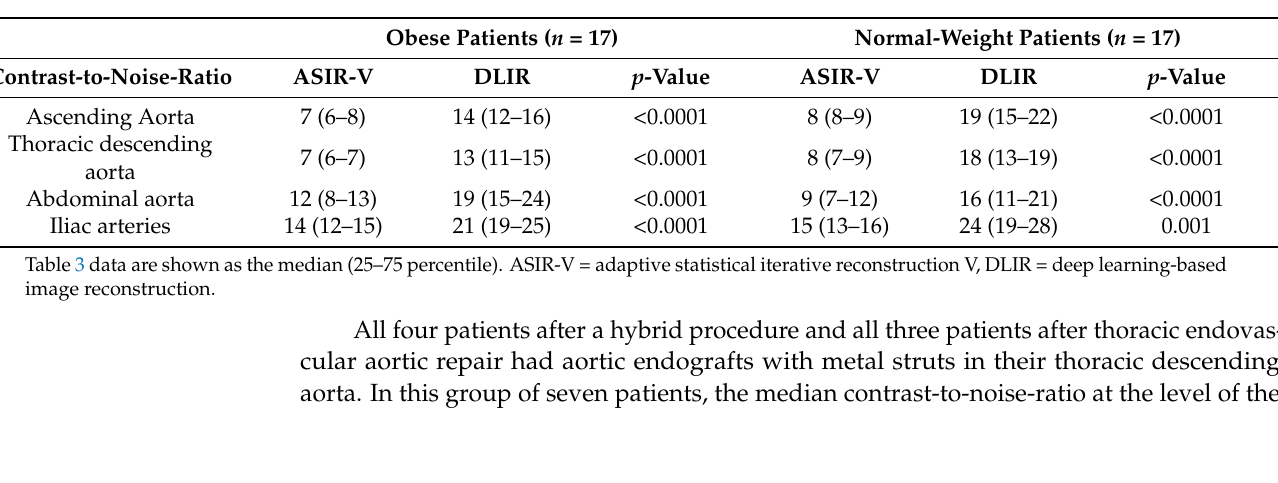
Table 3. Subgroup Table 3. Subgroup analysis.